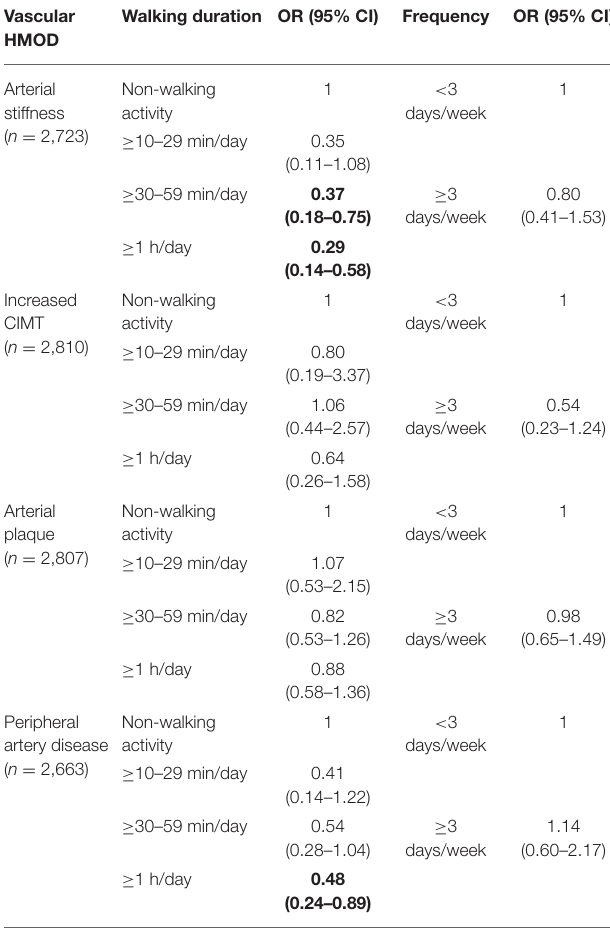
TABLE 5 | Risk of vascular HMOD across different walking duration and frequency after adjustment for moderate-to-vigorous physical activity. Vascular